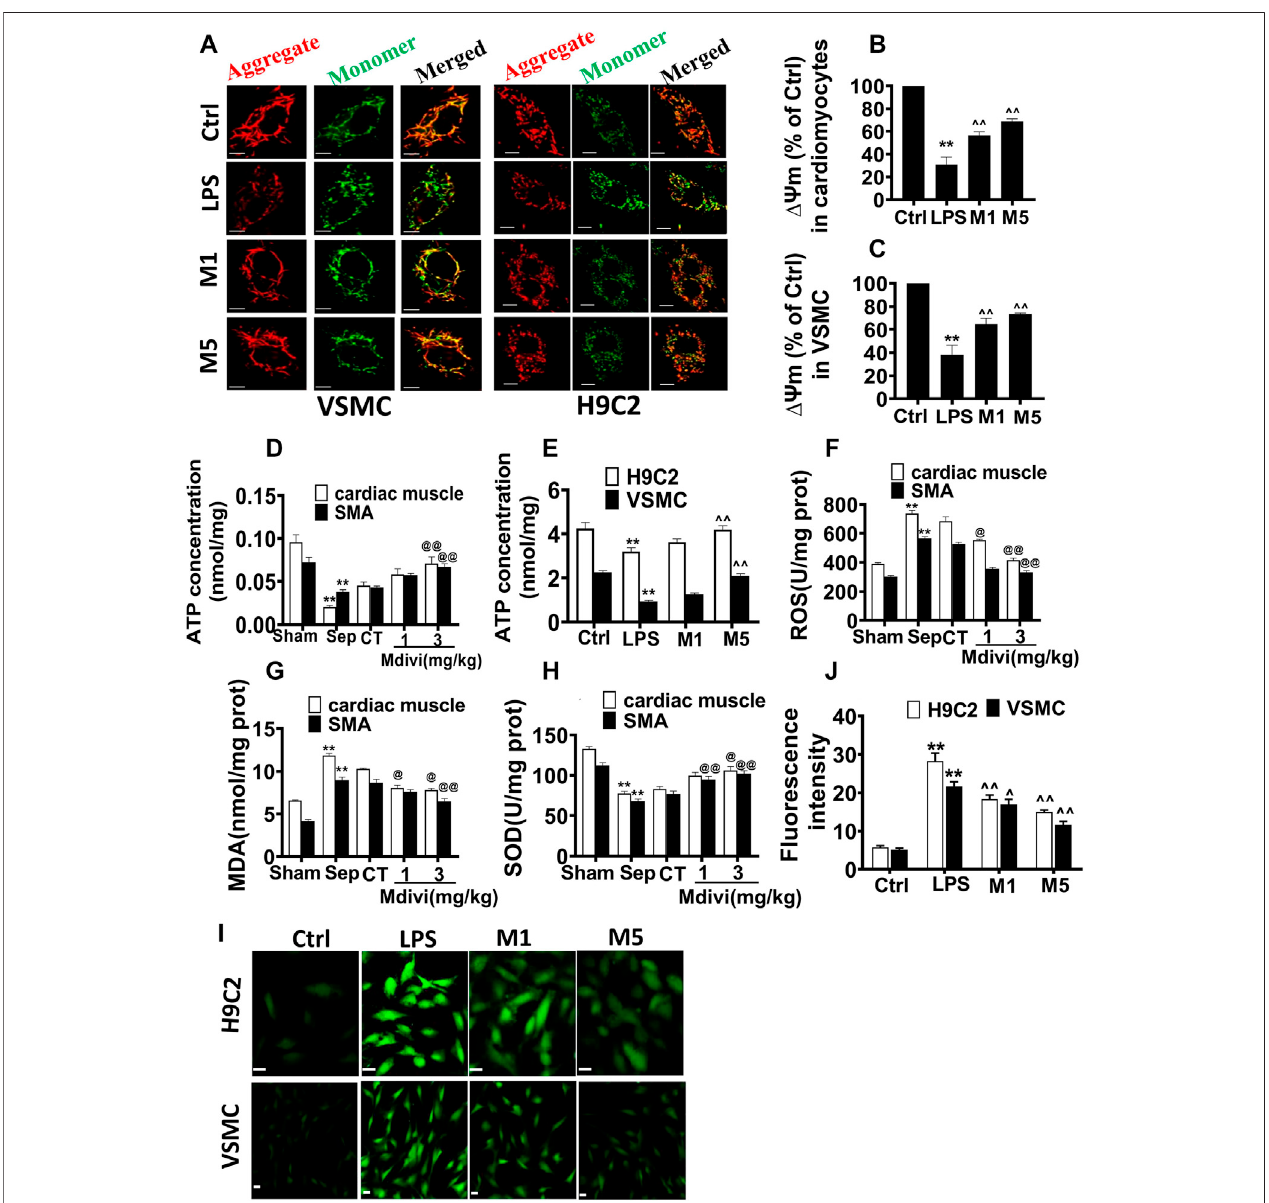
FIGURE 4 | Effects of Mdivi-1 on mitochondrial function in septic rats. (A – C) : mitochondrial membrane potential of cardiomyocytes and vascular smooth muscle cellsandstatisticalanalysis(bar (cid:1) 25 μ m). (D) :ATPconcentrationofhearttissueandsuperiormesentericarteria. (E) :ATPconcentrationofcardiomyocytesandvascular smoothmuscle cells. (F) :ROScontent incardiac muscleand superiormesenteric arteria. (G) : MDA content incardiac muscleand superiormesenteric arteria. (H) : SOD content in cardiac muscle and superior mesenteric arteria. (I,J) : ROS content in cardiomyocytes and vascular smooth muscle cell and statistical analysis (bar (cid:1) 25 µm). ** p < 0.01 versus sham or ctrl. @@ p < 0.01 versus conventional treatment (CT) group. ^^ p < 0.01 versus LPS. Sham (cid:1) the control group, Sep (cid:1) sepsis, CT (cid:1) conventional treatment. 1: Mdivi-1 (1 mg/kg). 3: Mdivi-1 (3 mg/kg). H9C2: cardiomyocytes. VSMC: vascular smooth muscle cell. Ctrl: control group. M1: Mdivi-1 (10 µM). M5: Mdivi-1 (50